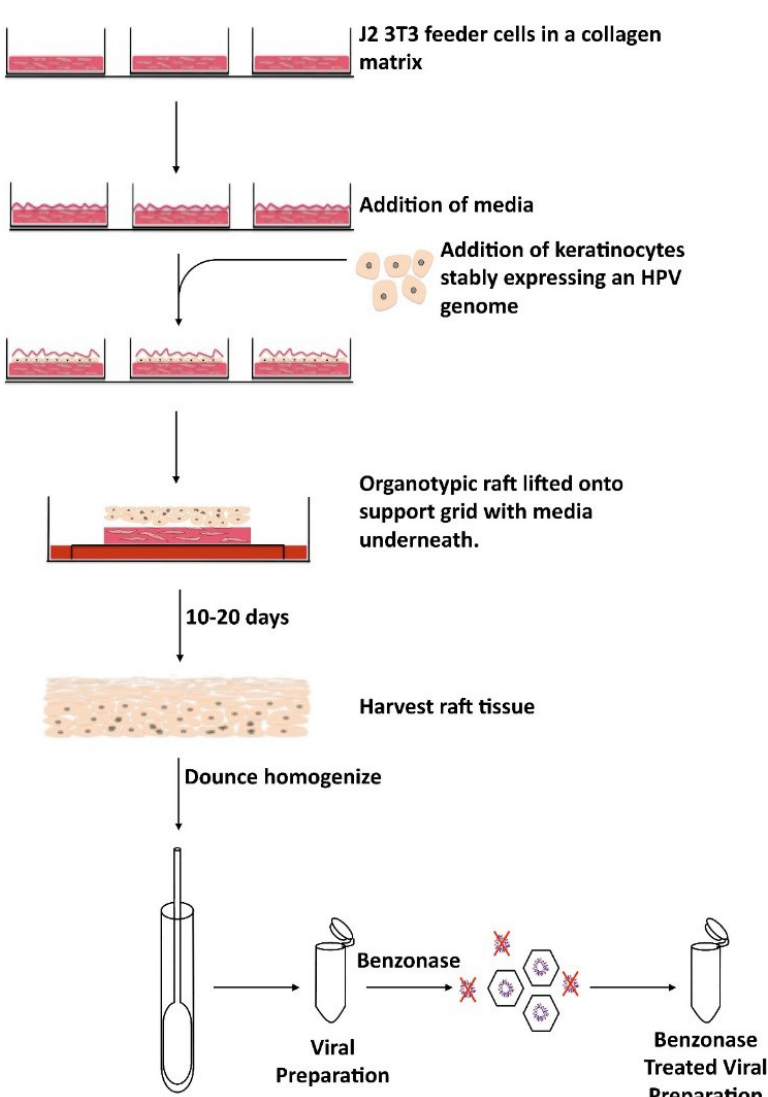
Figure 1. Schematic of native HPV virion production. HPV-positive cells are seeded on top of collagen plugs comprised of collagen and J2 3T3 feeder cells. Once the cells are have grown to confluence, the plugs are lifted onto a support grid. The rafts are then fed via diffusion from media underneath the grid. After 10–20 days, the tissue is harvested, homogenized, and benzonase treated to get a final viral preparation.